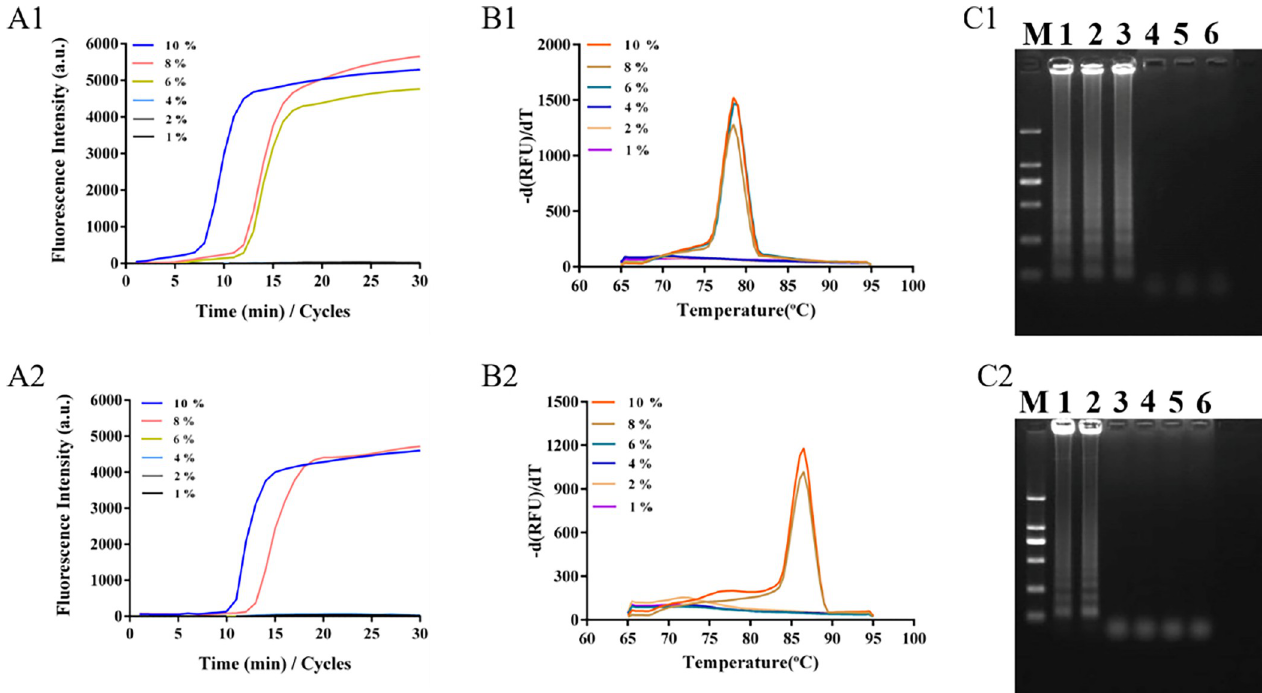
Fig 6. Sensitivity of LAMP detection with paper-based microfluidics extraction. Notes: A1, B1 & C1, the fluorescence amplification results, melting curve results, and agarose gel electrophoresis results of different peanut diluted samples; A2, B2 & C2, the fluorescence amplification results, melting curve results, and agarose gel electrophoresis results of different soybean diluted